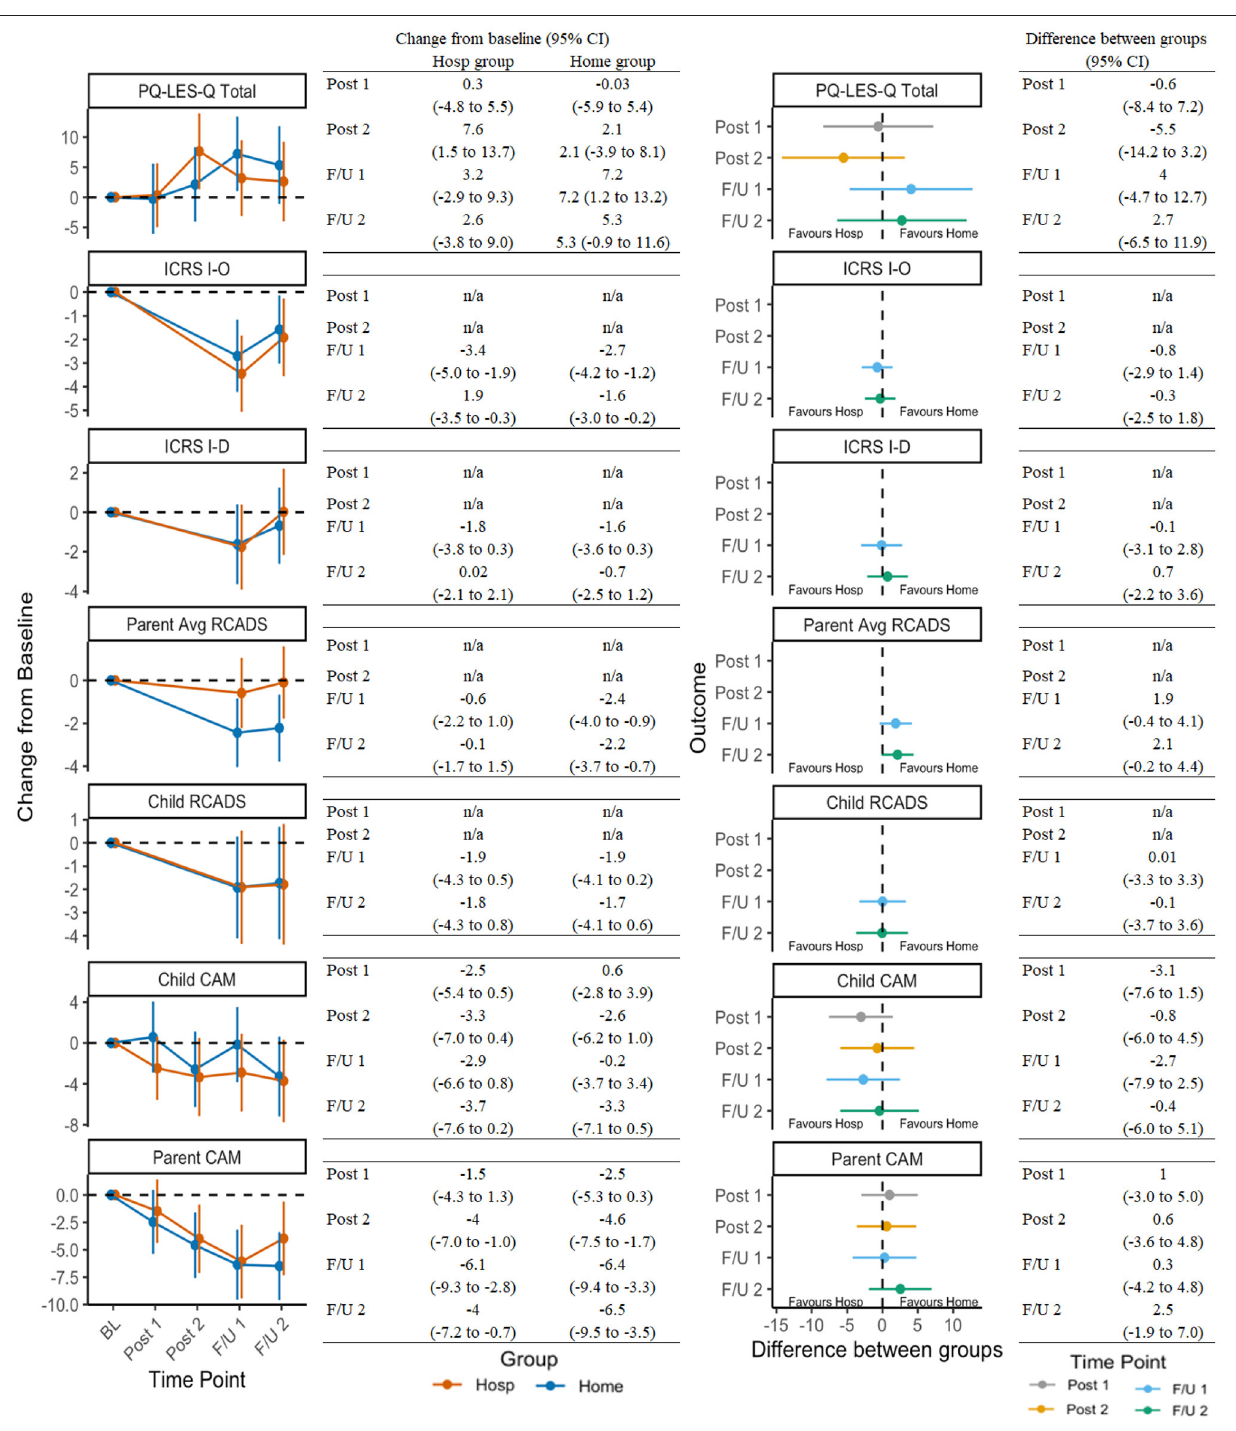
FIGURE 3 | Change in secondary outcomes across timepoints and between groups. See Table 1 for a list of all measure